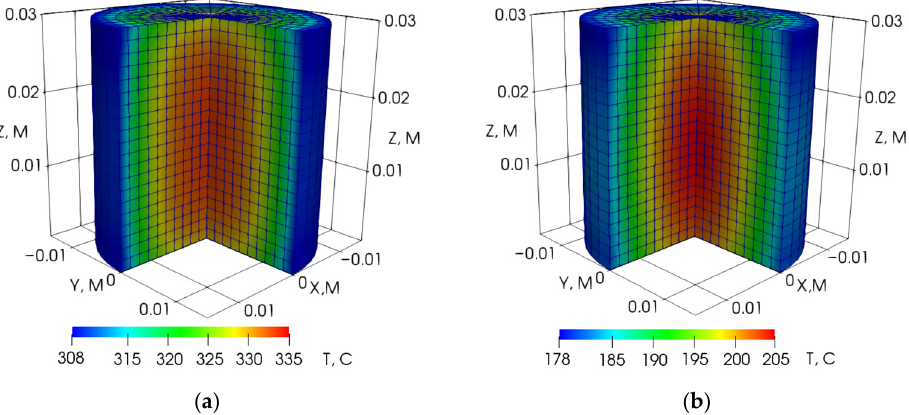
Figure 10. Temperature distribution in ( a ) sample B2 after 45 s of the microwave treatment; ( b ) sample B3 after 10 min of the radio-frequency treatment.